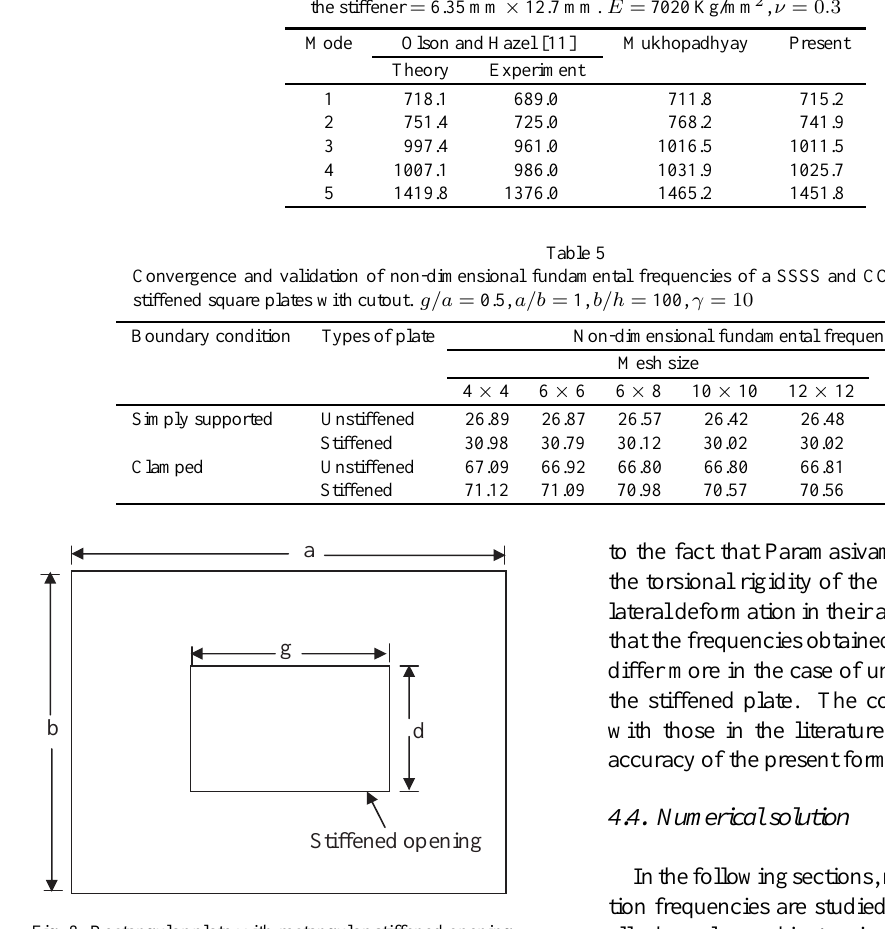
Fig. 8. Rectangular plate with rectangular stiffened